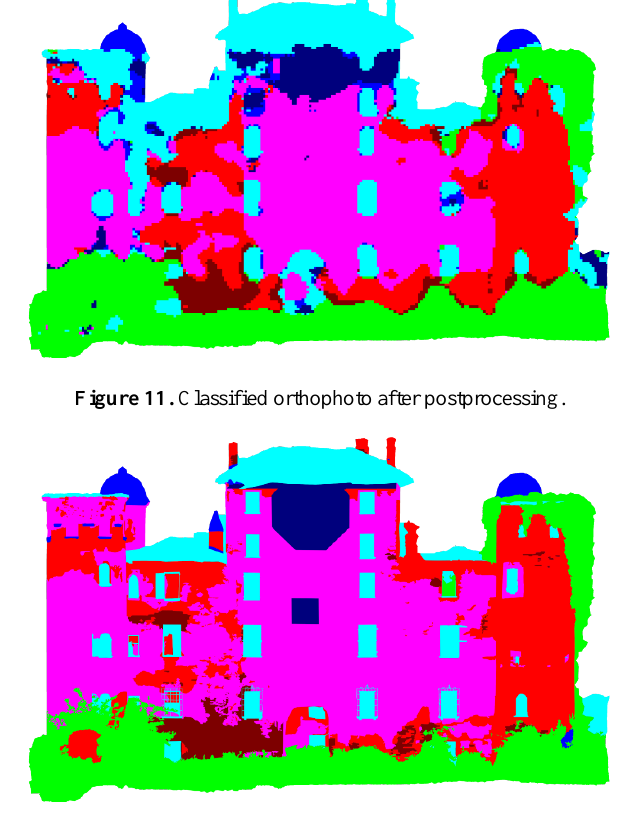
Figure 12. Orthophoto manually labelled by an operator, serving as ground truth to evaluate the results.